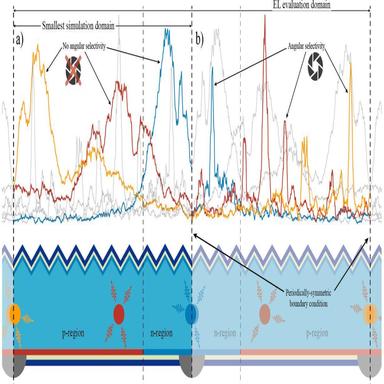
Representation of the smallest simulation domain and the extension of individual profiles to the EL evaluation domain due to periodically-symmetric boundary conditions. The effect of angular selectivity of the imaging system is also shown on a per-source basis.